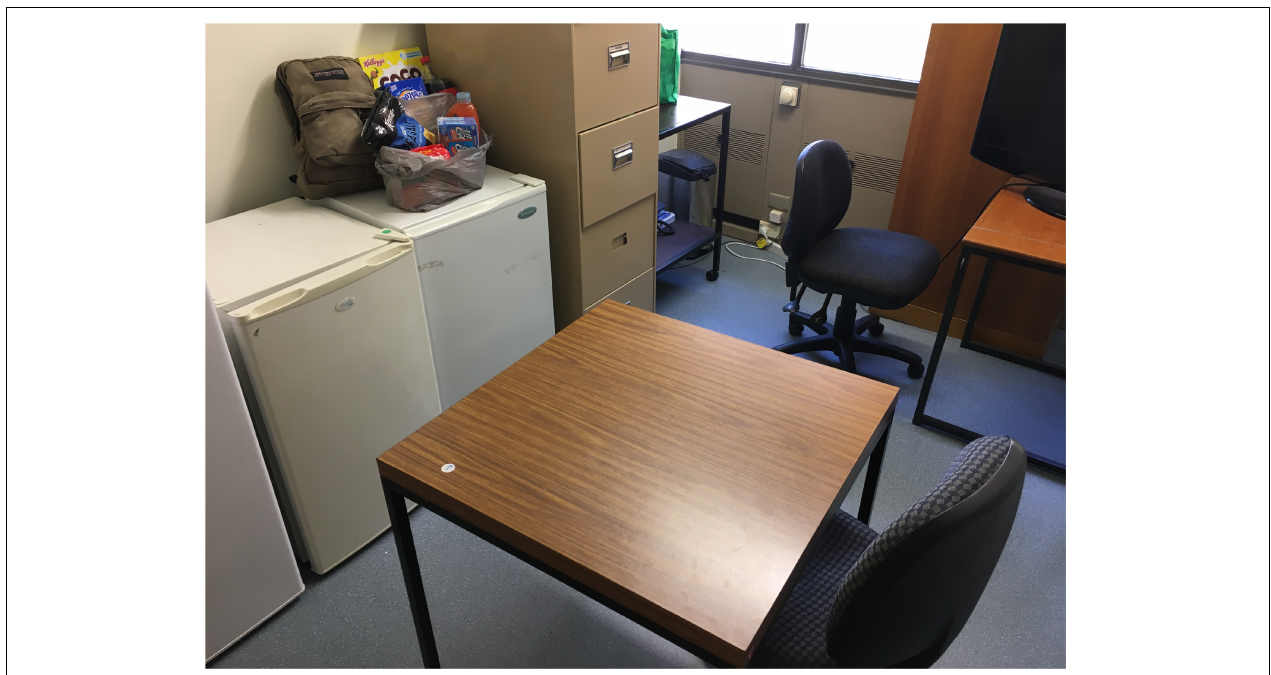
FIGURE 1 | The fictitious receiver’s belongings — bag and shopping — can be seen on the top of right-hand side bar fridge. Participants were asked to place their belongings next to this on the adjacent bar fridge and were seated in the chair and desk displayed in the bottom mid-right foreground of the